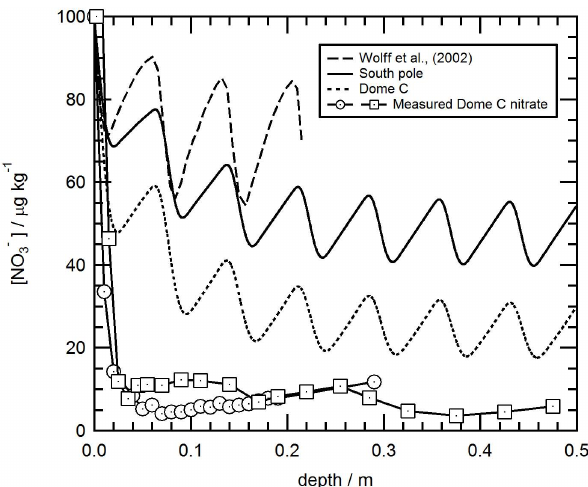
Fig. 6. Modelled depth-integrated production rates of NO 2 from a South Pole site (assuming the snowpack properties are the same as Dome C) as a direct comparison with the work of Wolff et al. (2002). The depth-integrated production rates of NO 2 (dotted circles) is calculated using the dotted circled nitrate profile from Fig. 2.